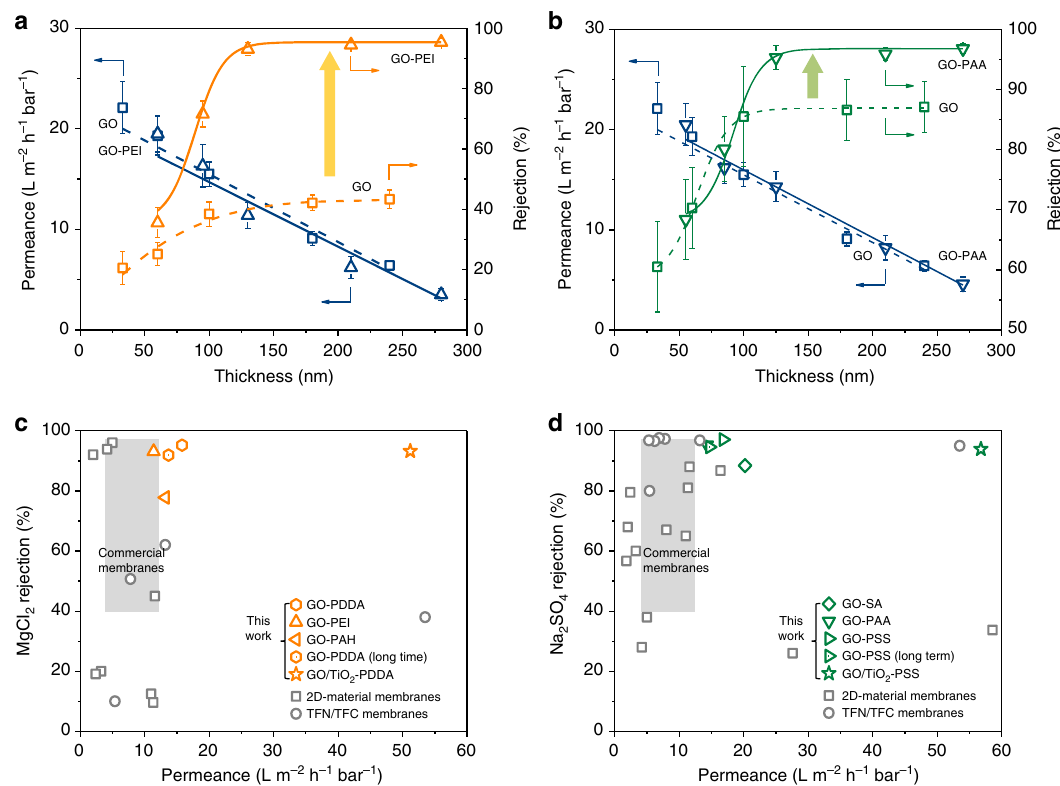
Fig. 3 Membrane performance comparison. a Water permeance and MgCl 2 rejection of pristine graphene oxide (GO) and positively charged GO-PEI membrane as a function of membrane thickness (GO deposition amounts of 0.1, 0.2, 0.5, 0.8, and 1.0 mg with 0.1 wt% polyethylene imine (PEI) surface coating) under 2 bar fi ltration at feed concentration of 50 ppm. b Water permeance and Na 2 SO 4 rejection of pristine GO and negatively charged GO-PAA membrane as a function of membrane thickness (GO deposition amounts of 0.1, 0.2, 0.5, 0.8, and 1.0 mg with 0.1 wt% polyacrylic acid (PAA) surface coating) under 2 bar fi ltration at feed concentration of 50 ppm. Dashed lines: pristine GO membranes; solid lines: surface-charged GO membranes. Yellow and green upward arrows indicate the remarkable improvements of surface-charged GO membranes in salt rejection. Error bars represent standard deviations for three measurements. c MgCl 2 rejection with water permeance of positively charged GO membranes (GO-PDDA marked as orange hexagon, GO-PEI marked as orange up-triangle, GO-PAH marked as orange left-triangle, GO-PDDA in long time measurement marked as orange spotted hexagon, TiO 2 intercalated GO-PDDA marked as orange star). d Na 2 SO 4 rejection with water permeance of negatively charged GO membranes (GO-SA marked as green hexagon, GO-PAA marked as green up-triangle, GO-PSS marked as green left-triangle, GO-PSS in long time measurement marked as green spotted hexagon, TiO 2 intercalated GO-PSS marked as green star) in this work, as well as comparison with two-dimensional-material membranes (marked as gray squares), thin fi lm nanocomposite (TFN) and/or thin fi lm composite (TFC) membranes (marked as gray circles), and commercial polymeric nano fi ltration membranes (marked as gray regions, e.g., NF270, NF90, NF200 membranes from Dow; DK, DL series of membranes from GE; ESNA series of membranes from Hydranautics). For references, see Supplementary Tables 2 and 3 in